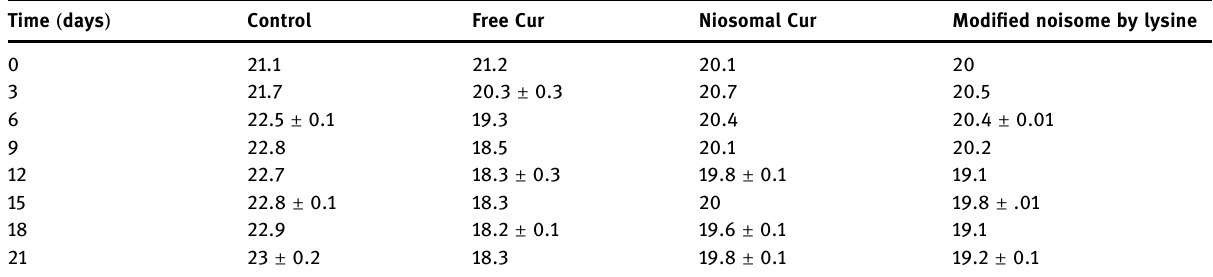
Table 4: Bodyweight of mice that received di ff erent therapies Time ( days